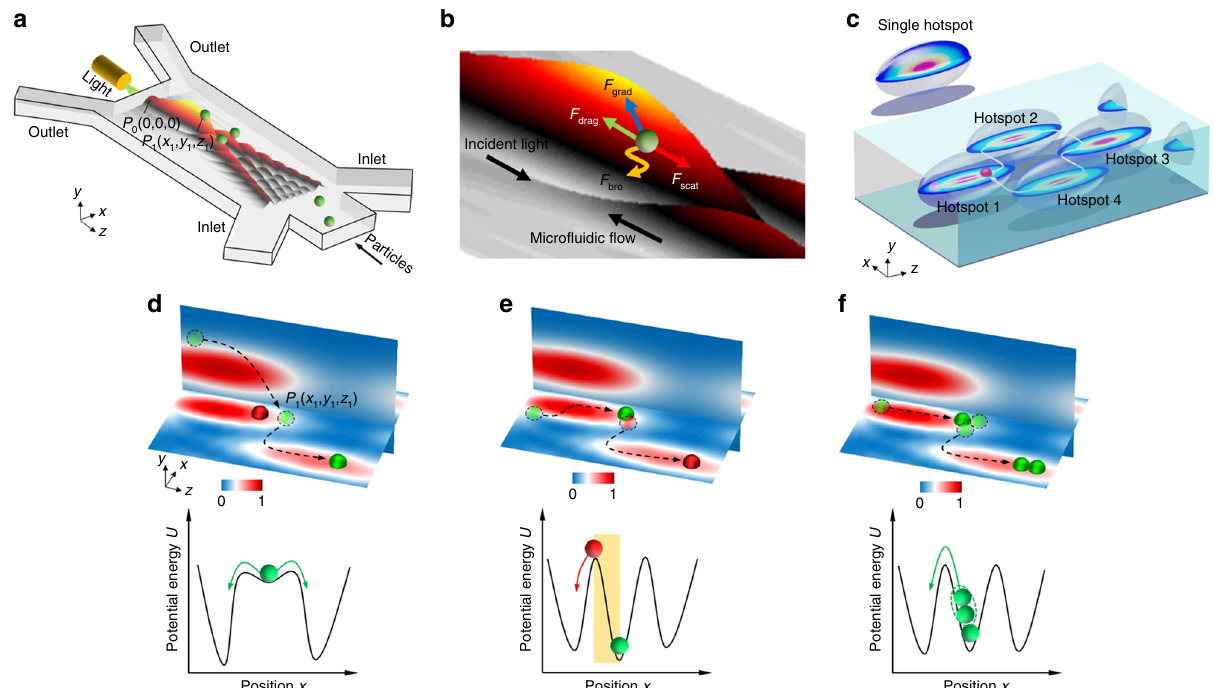
Fig. 1 The 2D controllable particle hopping in an opto fl uidic lattice. a Generation of the 2D lattice in an opto fl uidic chip. b Forces acting on a particle in the hotspot. c Illustration of the realisation of controllable particle hopping loop around the ellipsoid hotspots. Illustration of the simulated normalised light intensity (top row) and potential energy (bottom row) pro fi les of particle hopping triggered by three different mechanisms: d particle bypassing, e snookering-like particle collision and f particle aggregation. The intensity pro fi les in y – z plane (vertical) are slightly shifted from the central line ( x = 0) to have a better view of the particle